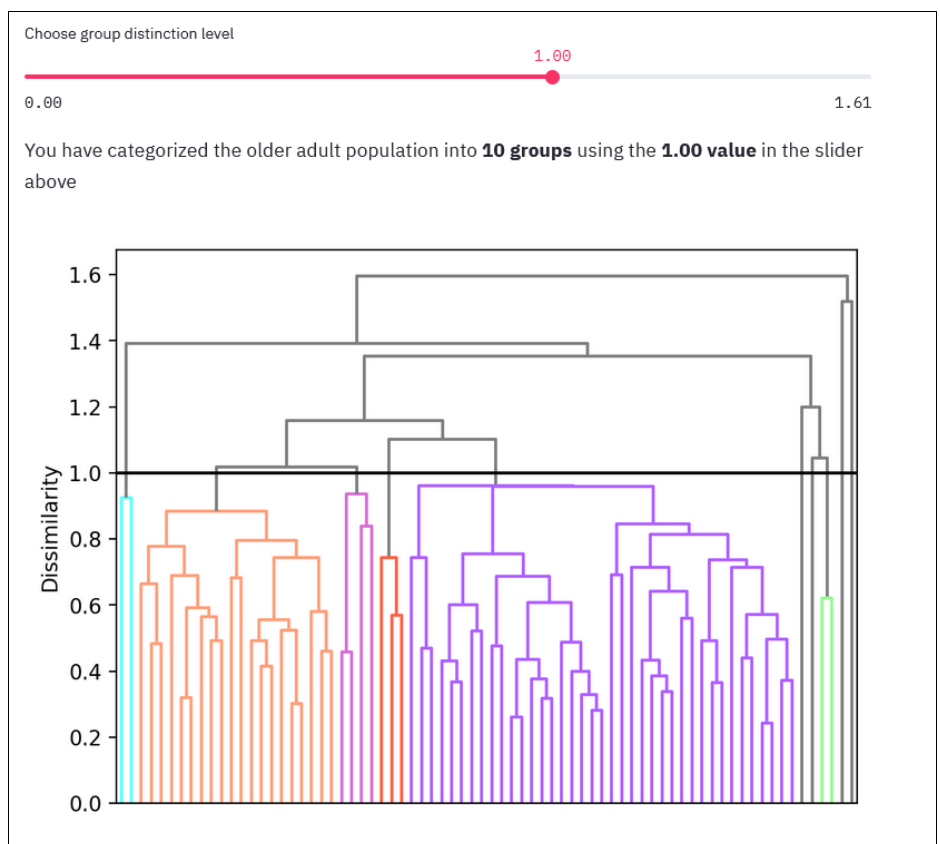
Figure 3. A dendrogram to create the grouping with its slider to select the dissimilarity level.